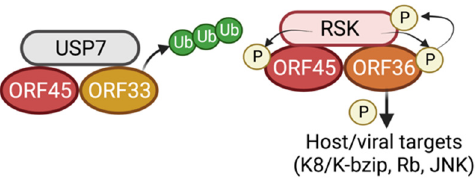
Figure 1. ORF45 interaction with viral proteins. (Left) ORF45 binds to viral tegument protein ORF33 via its C-terminus and stabilizes ORF33 via interaction with host de-ubiquitinase USP7, which prevents the ubiquitylation and proteasomal degradation of ORF33 (Right) ORF45 binds to the KSHV serine/threonine kinase ORF36 in a complex with host p90 ribosomal s6 kinase (RSK), which phosphorylates both viral targets at its target RxRxxS*/T* motif. This interaction promotes subsequent phosphorylation of RSK by ORF36, as well as phosphorylation of ORF36 downstream targets (e.g., K8, Rb, JNK).